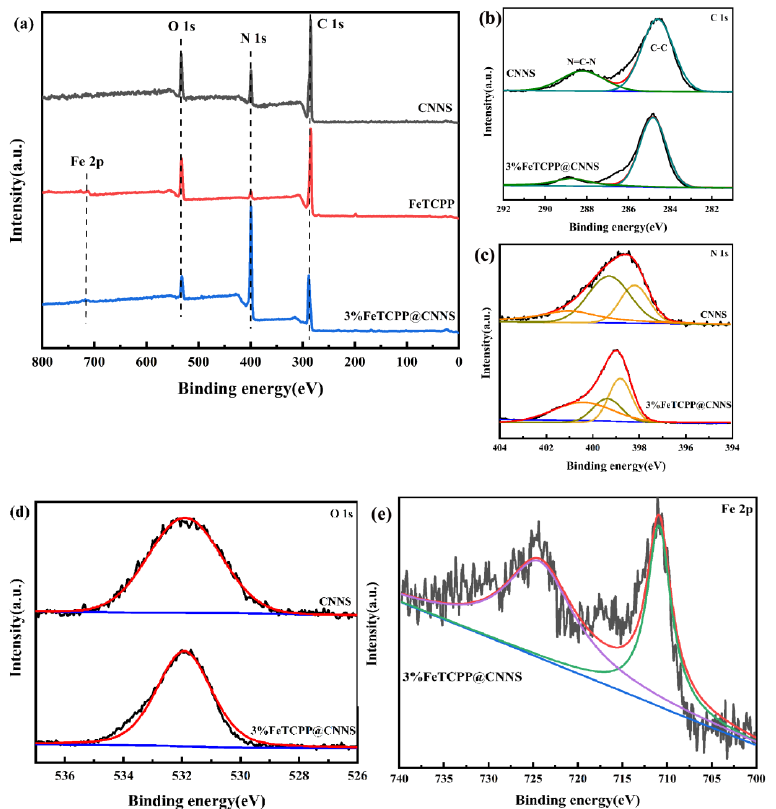
Figure 5. ( a ) XPS survey of CNNS, FeTCPP, and 3% FeTCPP@CNNS, ( b ) C 1s spectra, ( c ) N 1s spec- tra, ( d ) O 1s spectra of CNNS and 3% FeTCPP@CNNS, and ( e ) Fe 2p spectra of 3%